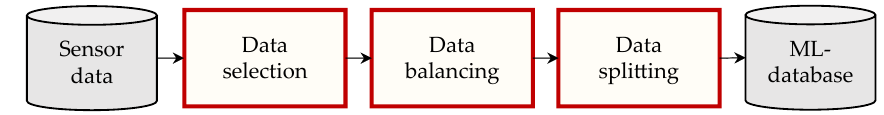
Figure 5. Methodology for the data